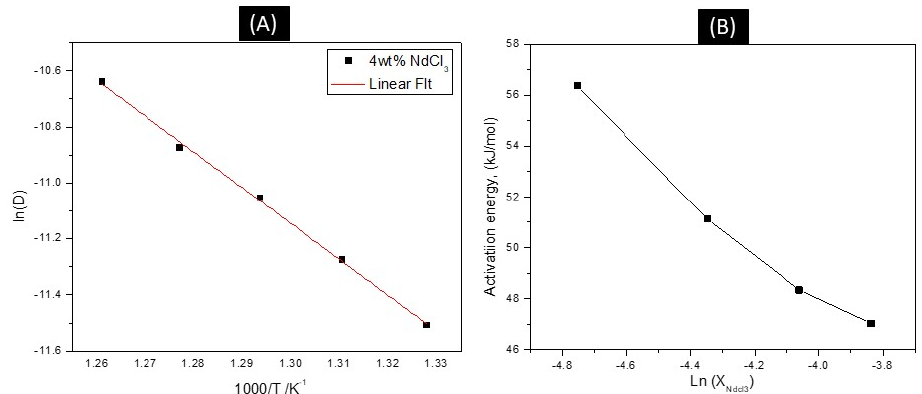
Figure 6. Diffusion coefficient changes as a function of NdCl 3 concentration in LiCl-KCl.